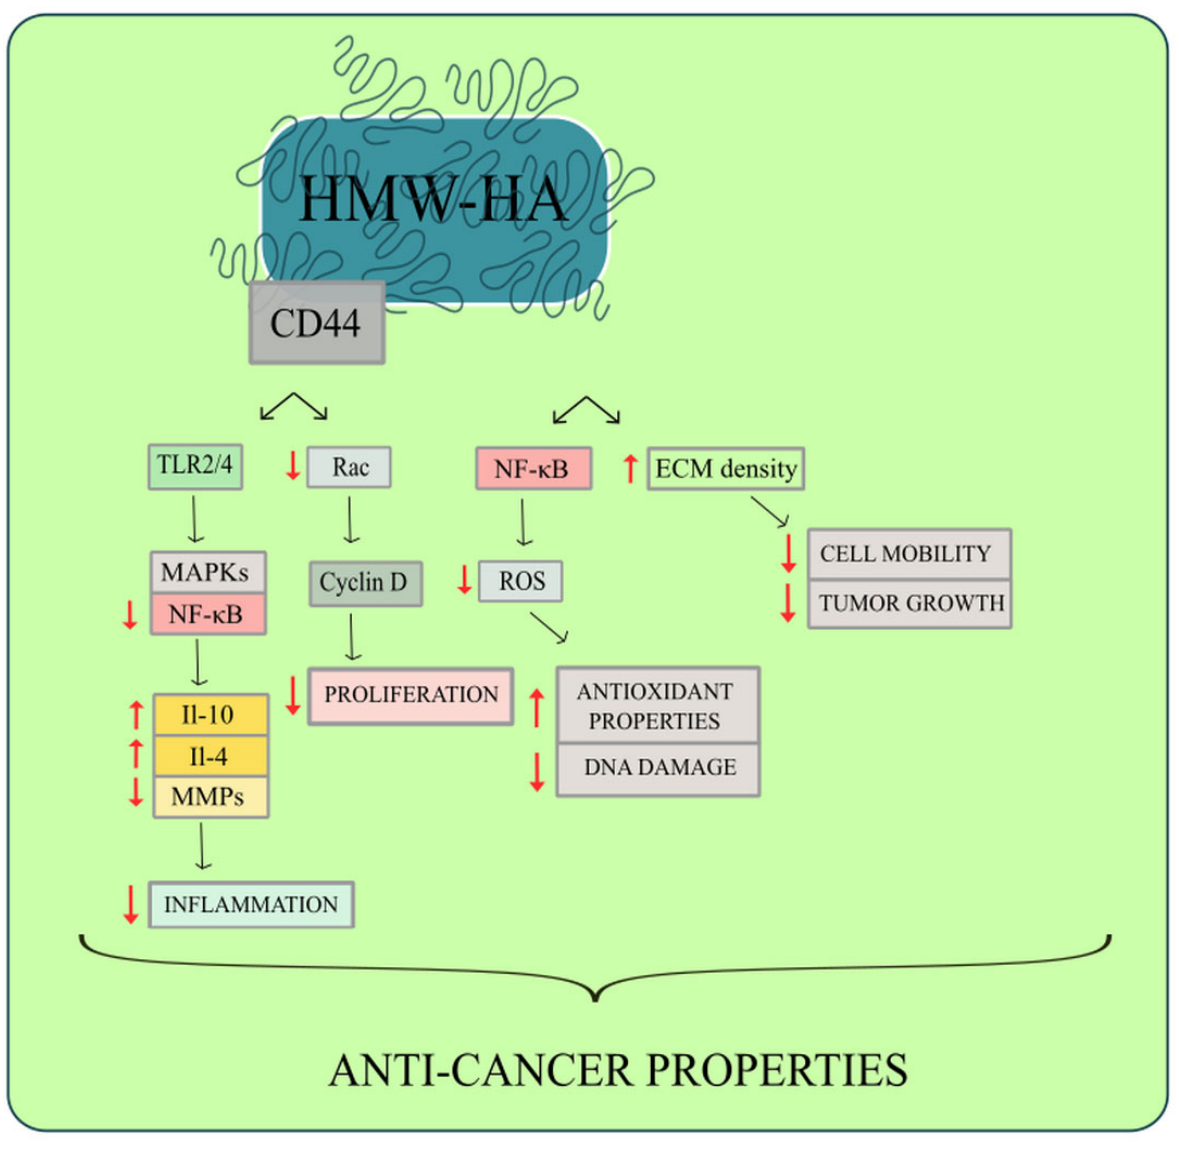
Figure 2. HMW-HA shows anticancer properties due to triggering a signaling cascade via the CD44 receptor. HMW HA binds to TLRs 2 and 4 and then inhibits MAPK and NF- κ B pathways, exhibiting anti-inflammatory effects by the production of IL-4 IL-10. Additionally, this signaling pathway diminishes MMP activation. Moreover, Cyclin D1 is inhibited by Rac-dependent signaling when HMW-HA binds to CD44. As a result, cell cycle progression and cell proliferation are suppressed. HMW-HA also increases ECM density, which prevents cell mobility and tumor growth. The ability of HMW-HA to reduce ROS activity and DNA damage is caused by NF-B regulation. Stimulation of intracellular processes and pathways by vHMW-HA accumulating in the ECM is essential for early contact inhibition (ECI) and suppression of oncogenic signals [59]. ECI is responsible for the inhibition of proliferation when cells interact with each other or with the ECM at significantly decreased densities [60]. The interaction of vHMW-HA with the CD44–NF2 pathway promotes contact inhibition, regulates ECI, and might trigger cell arrest [12]. The CD44 receptor interacts with neurofibromin 2 on the cytoplasmic surface. In NMR cells cultured with HAase, the phosphorylated, growth- promoting form of neurofibromin 2 was visible, but in cells cultured without HAase, the unphosphorylated, growth-inhibitory form of neurofibromin 2 predominated. In